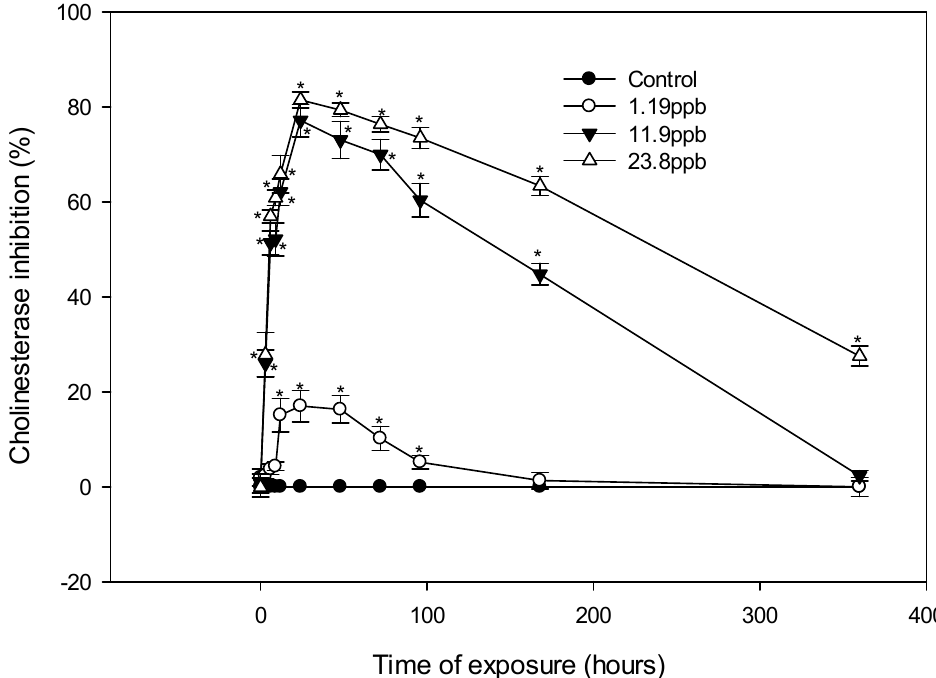
Figure 2. Trends of ChE inhibition after one exposure. Data are presented as the mean of 6 fish, with vertical bars representing the standard error. An asterisk (*) indicates significant difference to parallel control ( p < 0.05).